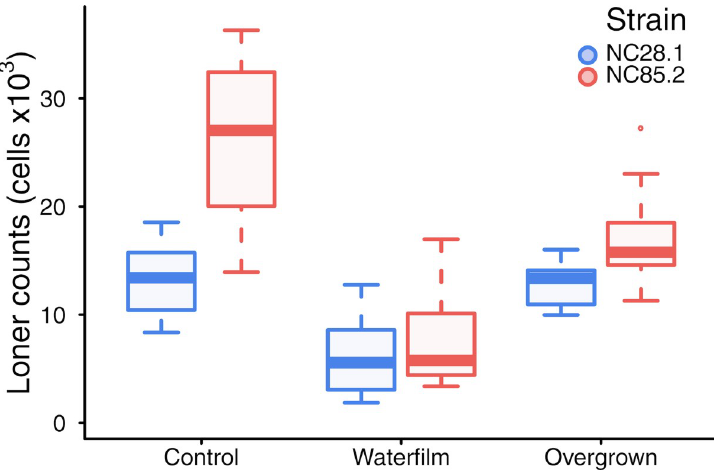
Fig 3. Well-mixed signaling changes loner behavior. Adding a thin film of water that dries after 4 hours (before aggregation begins) decreases the number of loners for both strains ( p < 0.000001). Furthermore, allowing cells to exhaust their resources in suspension does not significantly change the behavior of the better aggregator (strain NC28.1) ( p = 0.7), but it reduces the mean and variance of the number of loners of the worse aggregator (strain NC85.2) ( p = 0.0006). The control is an independent replicate of the experiments in the framed portion of Fig 1E. Boxes, interquartile ranges; horizontal lines, medians; whiskers, 1.5 × interquartile range from the median; points,